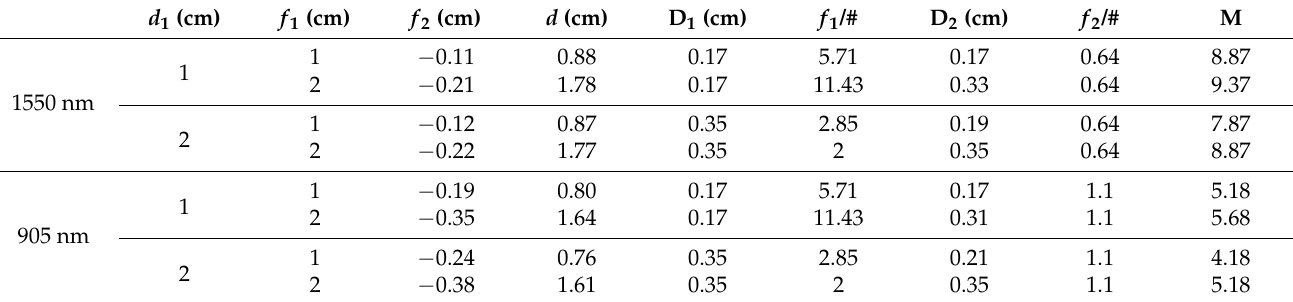
Table 2. The parameters involved in the calculation for the whole magnification system. The incident angle is set at 5 ◦ . d 1 : the distance between OPA and BAE; f 1 : focal length of the first PB lens (L 1 ); f 2 : focal length of the second PB lens (L 2 ); d : the distance between L 1 and L 2 ; D 1 : diameter of L 1 ; f 1 /#: f -number of L 1 ; D2: diameter of L 2 ; f 2 /#: f -number of L 2 ; M: magnification factor. The minus sign of f 2 indicates L 2 is a negative